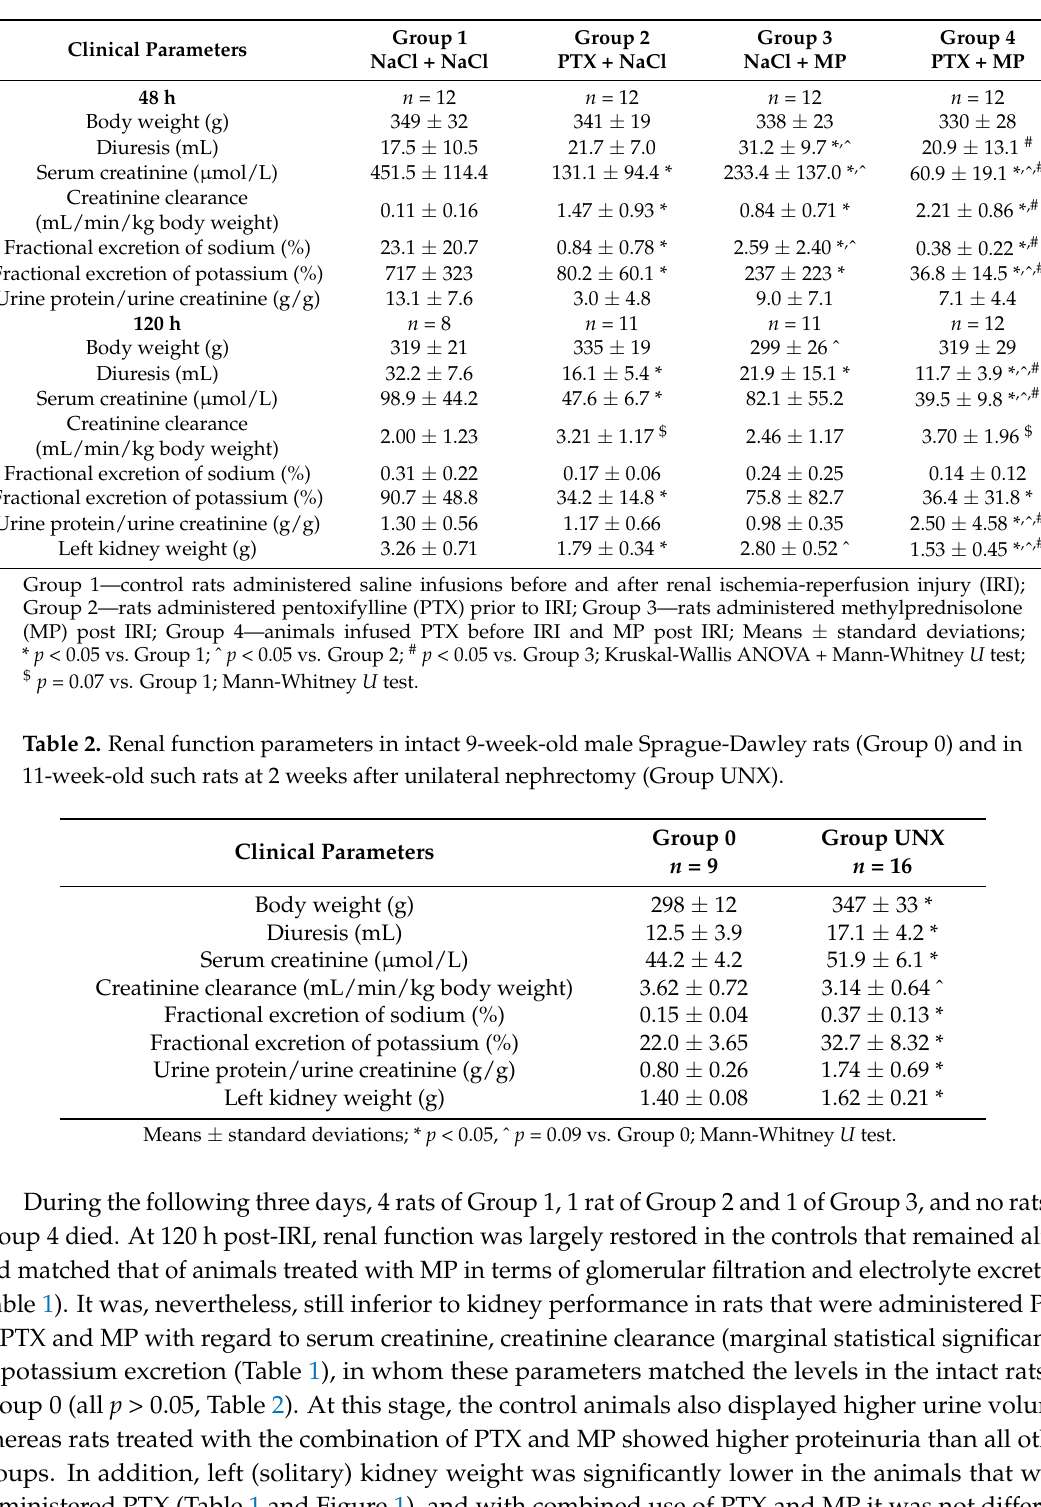
Table 1. Acute kidney injury model—renal function parameters at 48 and 120 h after the ischemia-reperfusion of the solitary kidney.